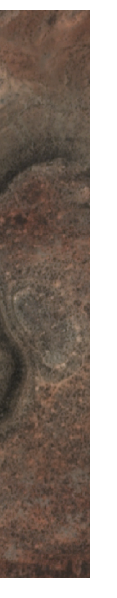
Figure 4. Sample of an annotated mask tile